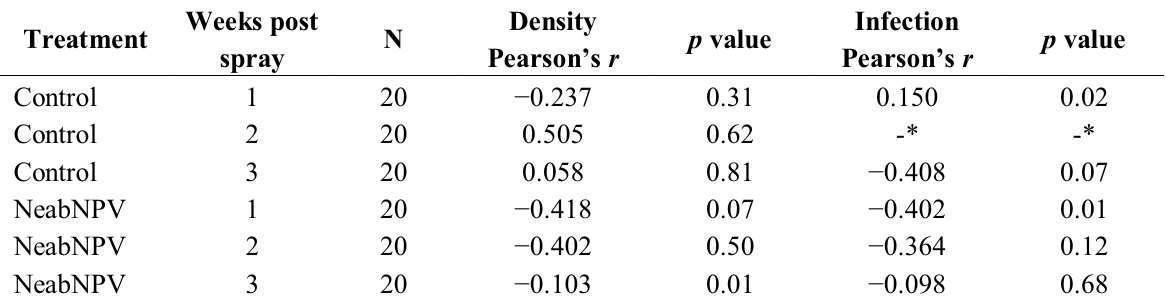
Table 2. (cid:50)(cid:79)(cid:71)(cid:3)(cid:48)(cid:68)(cid:81)(cid:182)(cid:86)(cid:3)(cid:51)(cid:82)(cid:81)(cid:71)(cid:3)(cid:21)(cid:19)(cid:19)(cid:21)(cid:17)(cid:3)(cid:54)(cid:88)(cid:80)(cid:80)(cid:68)(cid:85)(cid:92)(cid:3)(cid:82)(cid:73)(cid:3)(cid:51)(cid:72)(cid:68)(cid:85)(cid:86)(cid:82)(cid:81)(cid:3)(cid:70)(cid:82)(cid:85)(cid:85)(cid:72)(cid:79)(cid:68)(cid:87)(cid:76)(cid:82)(cid:81)(cid:3)(cid:68)(cid:81)(cid:68)(cid:79)(cid:92)(cid:86)(cid:72)(cid:86)(cid:3)(cid:86)(cid:75)(cid:82)(cid:90)(cid:76)(cid:81)(cid:74)(cid:3)(cid:90)(cid:72)(cid:72)(cid:78)(cid:79)(cid:92)(cid:3) trends in the relationship between distance from the two spray swaths separated by 200 m in the treatment block and the untreated (control) block and, juvenile balsam fir sawfly densities and the prevalence of NeabNPV infection in juvenile balsam fir sawfly (cid:83)(cid:82)(cid:83)(cid:88)(cid:79)(cid:68)(cid:87)(cid:76)(cid:82)(cid:81)(cid:86)(cid:17)(cid:3)(cid:55)(cid:75)(cid:72)(cid:3)(cid:179)(cid:71)(cid:76)(cid:86)(cid:87)(cid:68)(cid:81)(cid:70)(cid:72)(cid:3)(cid:73)(cid:85)(cid:82)(cid:80)(cid:3)(cid:86)(cid:83)(cid:85)(cid:68)(cid:92)(cid:180) values used for the treatment block were also used for the control block, assuming that spray swaths would have occurred in the same location as in the treatment.